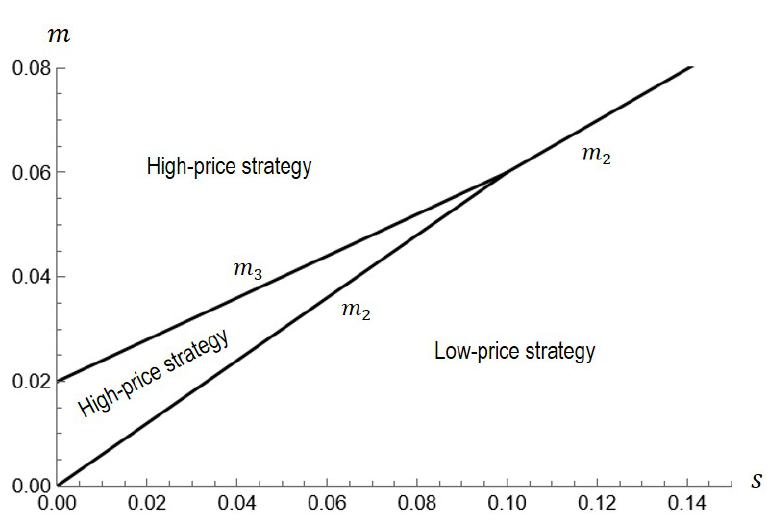
Figure 4. Seller’s pricing strategy in scenario RN ( c = 0.4, θ = 0.6, λ l = 0.4, λ h = 0.6, β = 2, h =